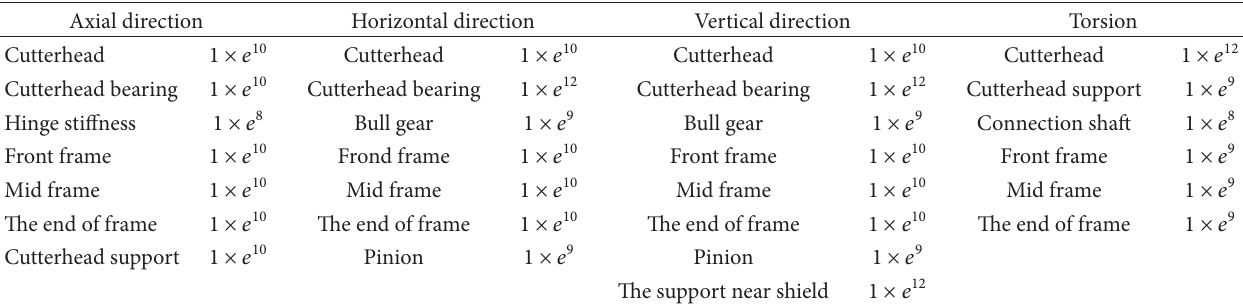
Table 3: The stiffness distribution of the TBM